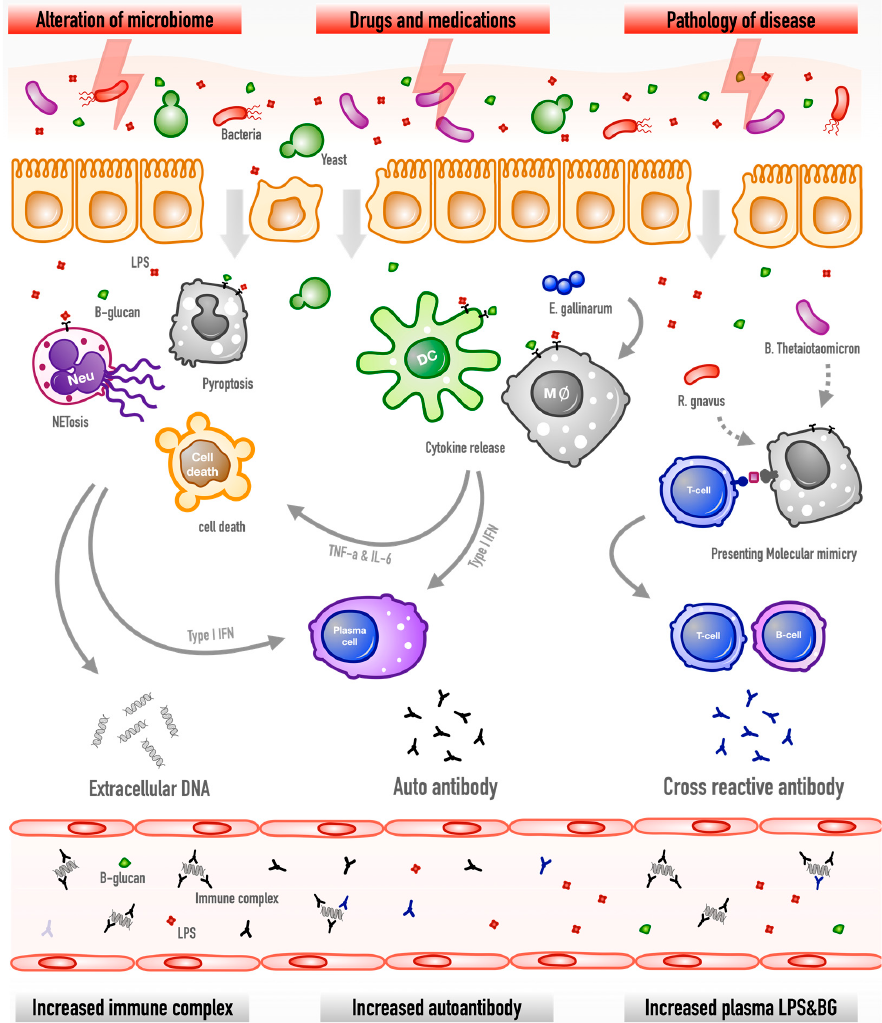
Figure 3. The hypothesis diagram demonstrates gut permeability defects in lupus through several mechanisms (microbiome alteration, drugs, and lupus-induced inflammation) facilitate the translocation of microbial molecules that induce the death of immune cells (apoptosis, NETosis, and pyroptosis), the release of cytokines (type I IFN and IL-6), and molecular mimicry, results in extracellular DNA exposure, autoantibody production, and cross-reactive antibodies. Hence, leaky gut might enhance pathogen molecules in the blood, such as lipopolysaccharides (LPS) from Gram-negative bacteria and (1 → 3)- β - D -glucan (BG) from gut fungi, autoantibody production, and the circulating immune complex.